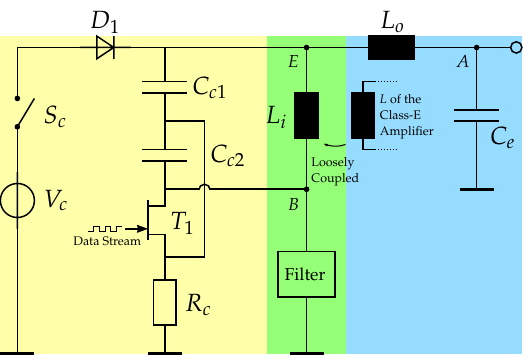
Figure 2. Interconnected oscillators: the yellow marked components correspond to the data transmit- ting sub-circuit; the blue marked ones to the energy receive sub-circuit, and the green ones are the shared components for both sub-circuits.